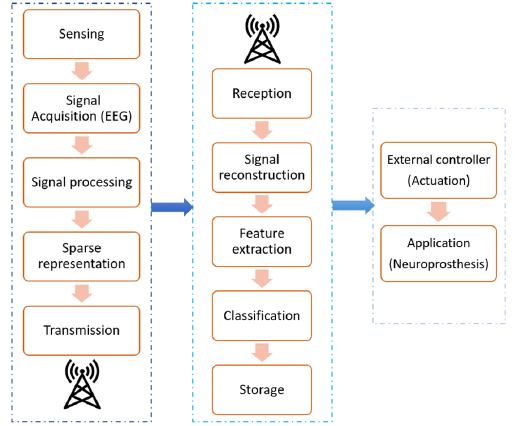
Figure 1. The compressive sensing system for EEG signals for BCI applications. In the transmission stage, the signals are represented sparsely. At the receiver end, the sparse signals are reconstructed, and features are extracted for classification and used for neuroprosthesis applications.